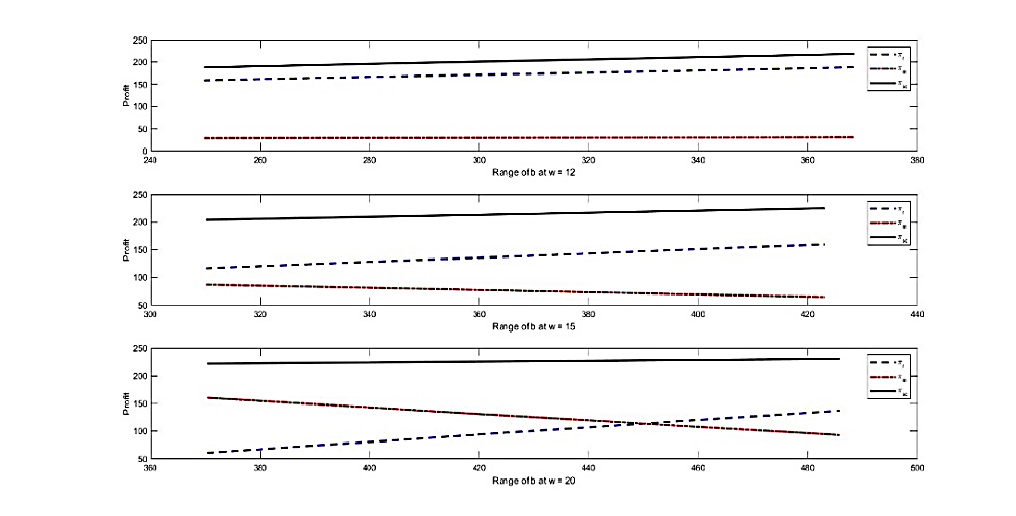
Based on the results of the analysis obtained from the wholesale price variations on the firms 'profits post contract, it is observed that the profit of the whole network and the profit of each member of the chain in the contract state is higher than the members' profit in the decentralized state . Also, with the increase in maintenance costs, the variations trend of the profit of the entire supply chain network decreases .